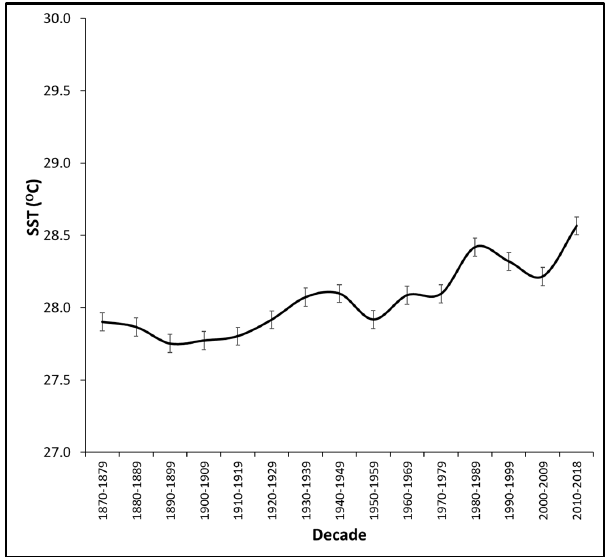
Figure 6. Decadal SST variation in the study area from 1870 to 2018. The black, straight lines indicate the standard error.